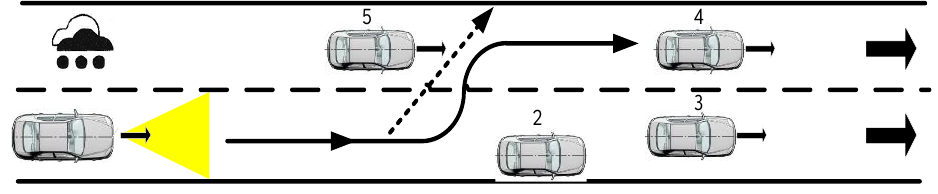
Figure 22. Highway scene with heavy rain.